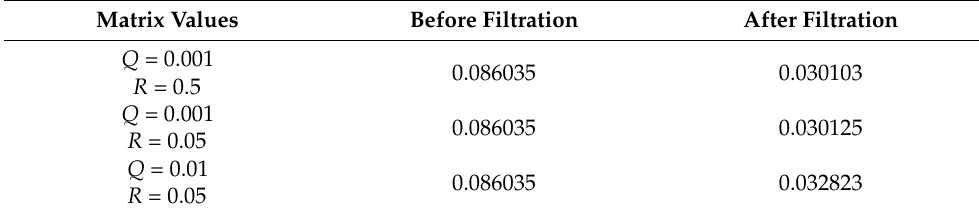
Table 4. Error covariance of Kalman filter at selected values of Q and R matrices. Matrix